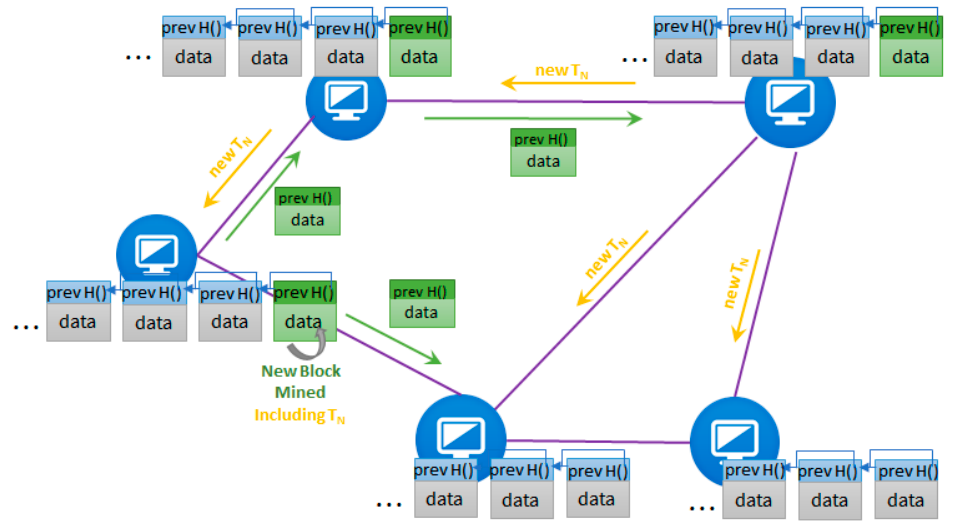
Figure 2. Ledger distribution in peer-to-peer network.